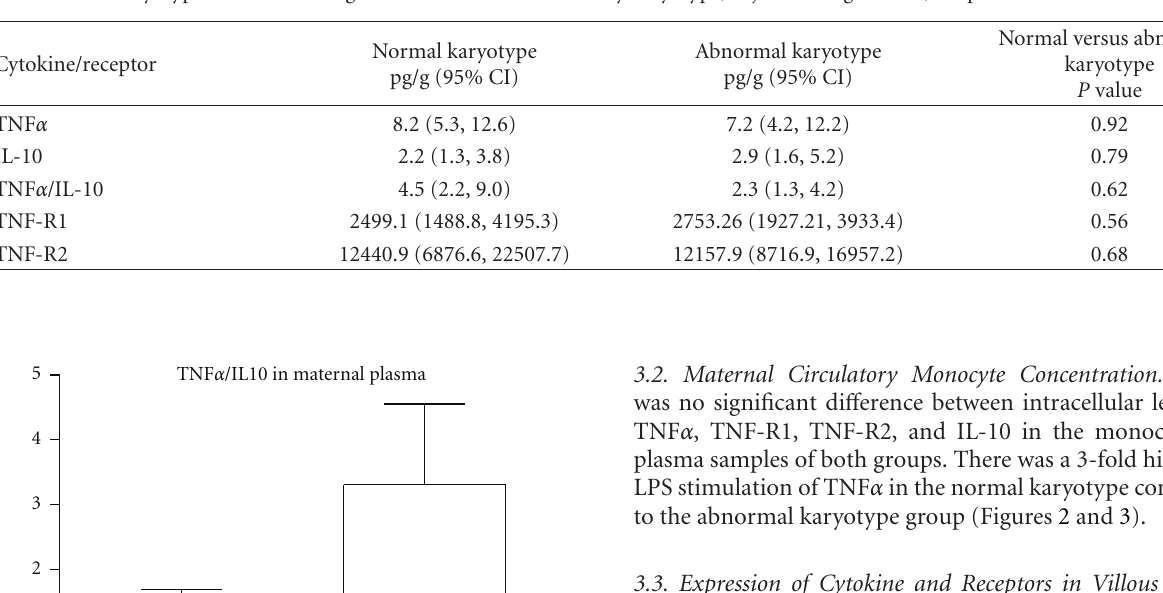
Table 1: In vivo cytokine and receptors, measured in snap frozen villous tissue collected on the day of ERPC—comparison done using 2-way ANOVA, using the variables of karyotype (normal versus abnormal) and gestation (weeks). There was no significant di ff erence between gestation and karyotype. Estimated marginal means for each marker by karyotype, adjusted for gestation, are presented here.